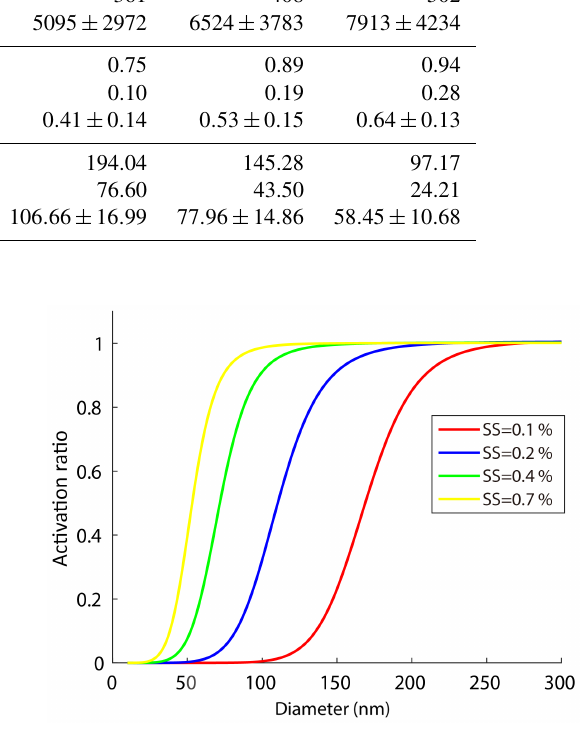
Figure 4. The size-resolved activation ratios measured by the SMCA at four different supersaturations. Note that the curves were fitted according to the SMCA